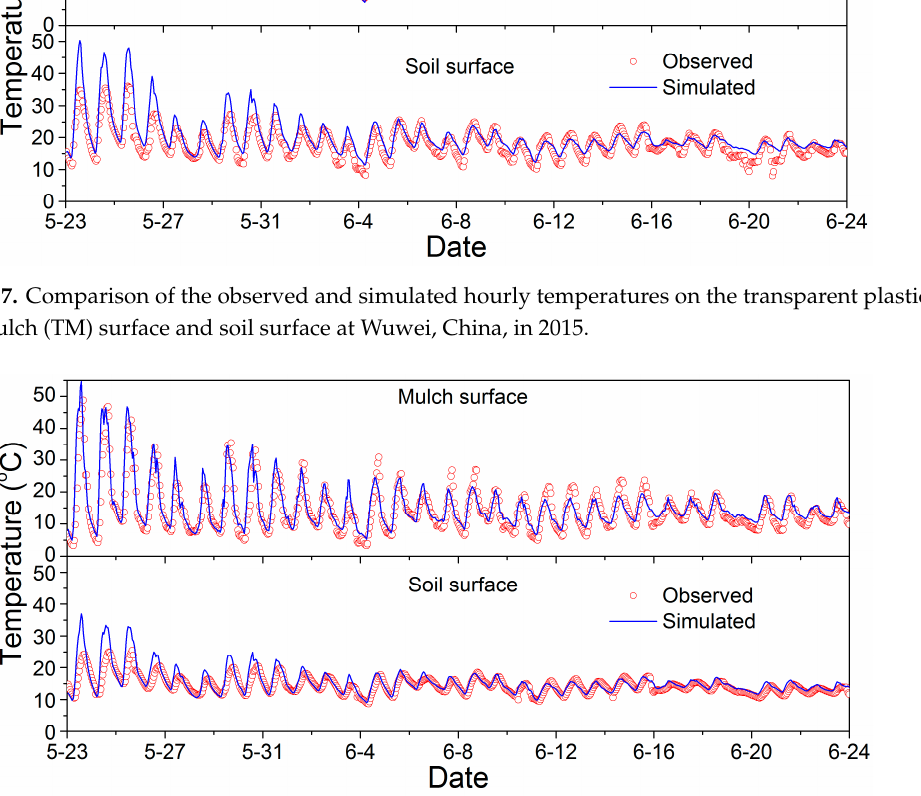
− 1.1 Table 5. The root mean square errors (RMSE) and coefficient of determination ( R 2 ) in simulated and observed daily temperatures (on mulch surface and soil surface) for the transparent plastic film mulch and black plastic film mulch treatments at Wuwei, China. Season Parameters Transparent Plastic Film Mulch